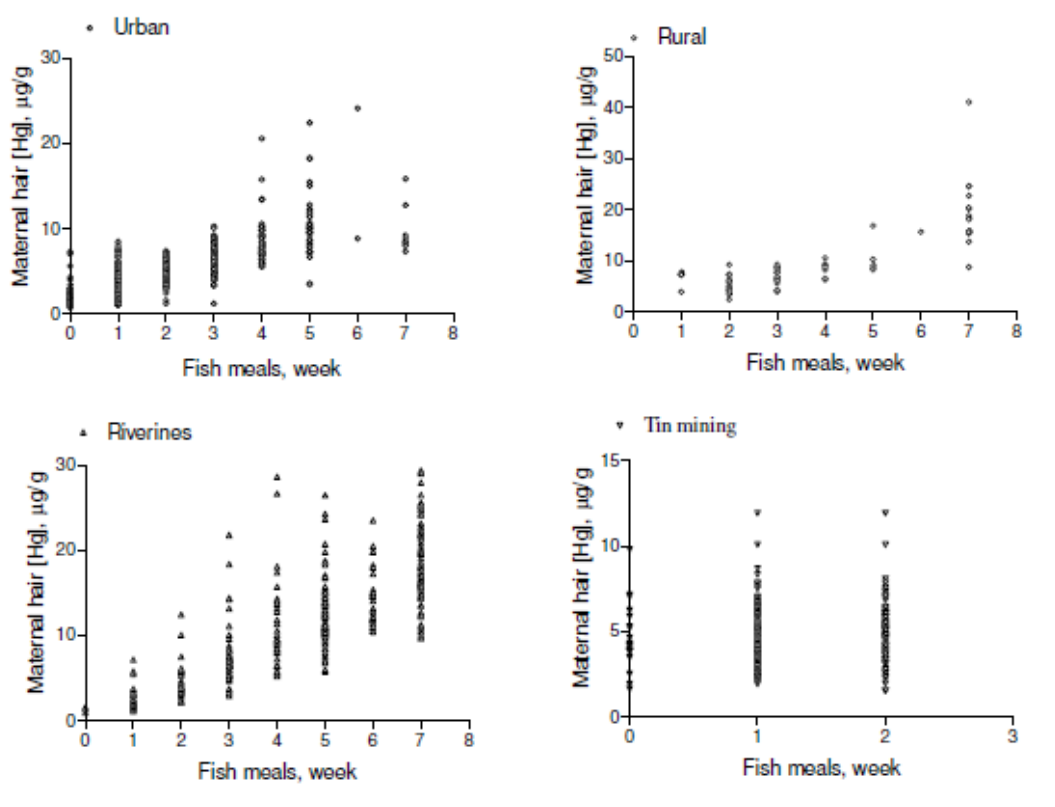
Figure 2. Scatter plot of total hair-Hg concentrations as a function of maternal fish